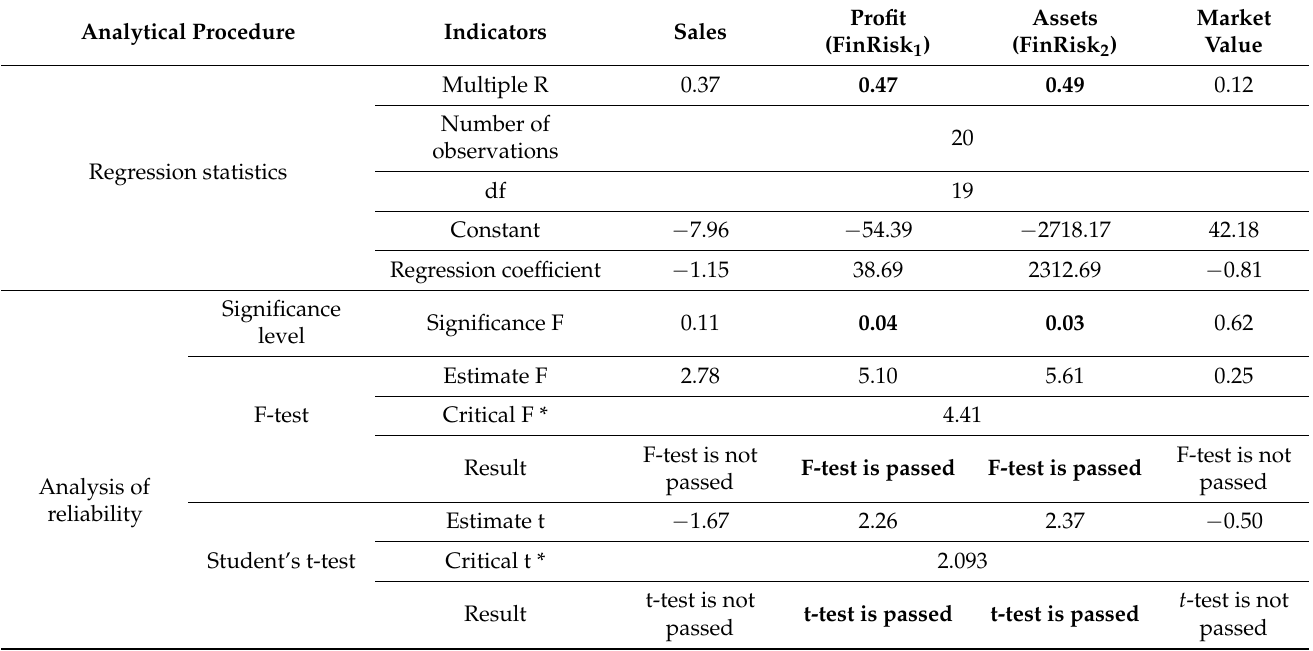
Table 2. Regression analysis of the sample.